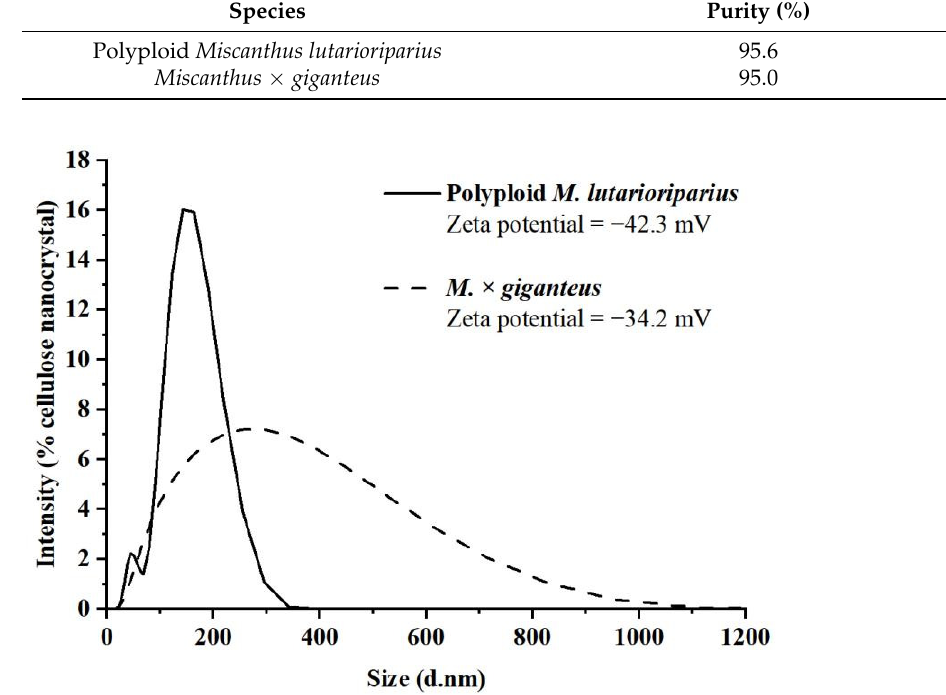
Figure 6. Particle size distribution, zeta potential of CNC in polyploid Miscanthus lutarioriparius and Miscanthus × giganteus .